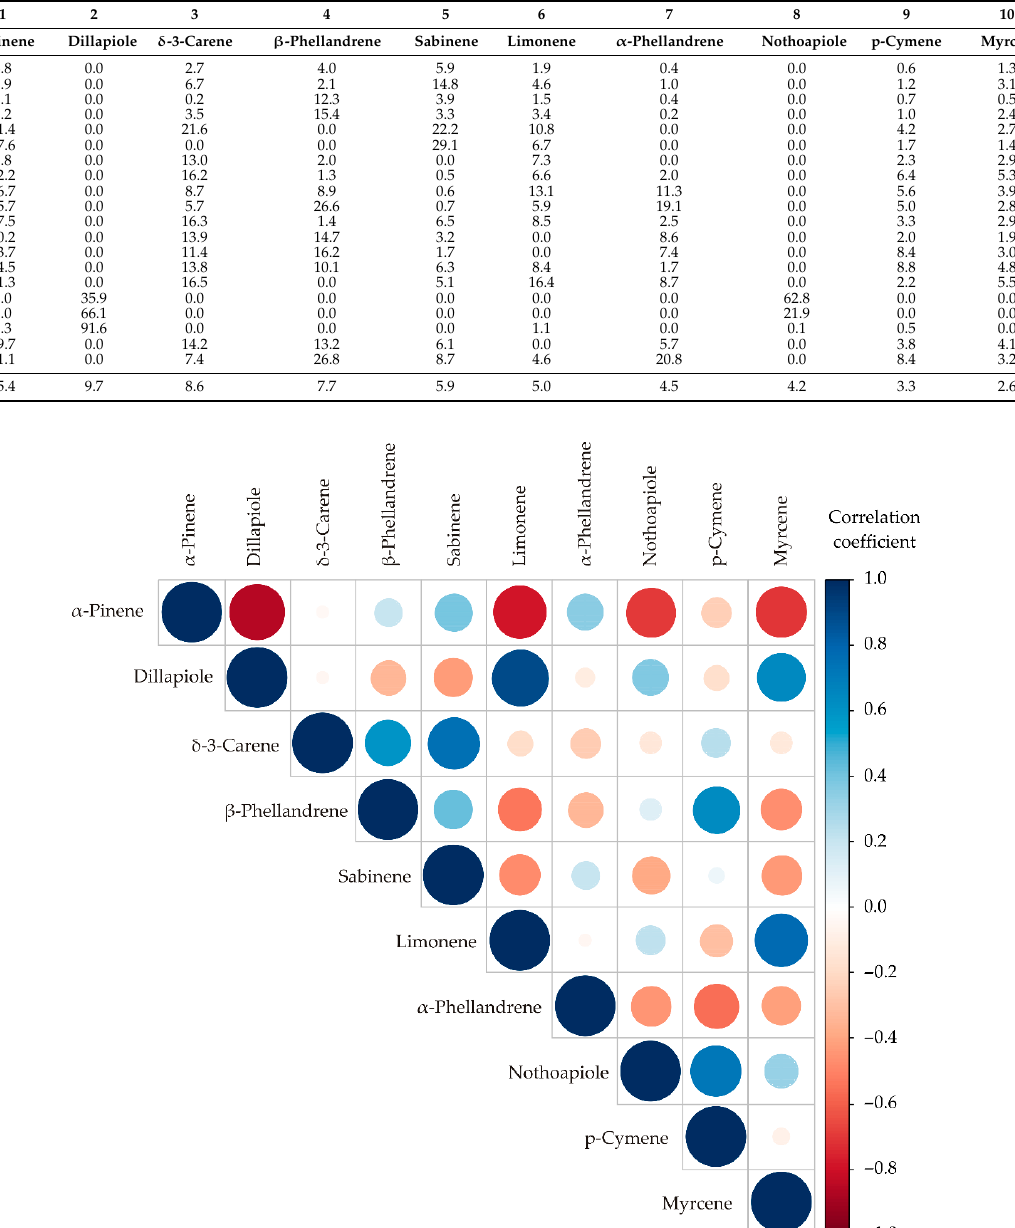
Table 1. Chemical compositions of different A. archangelica root volatile compounds of accession according to the literature.